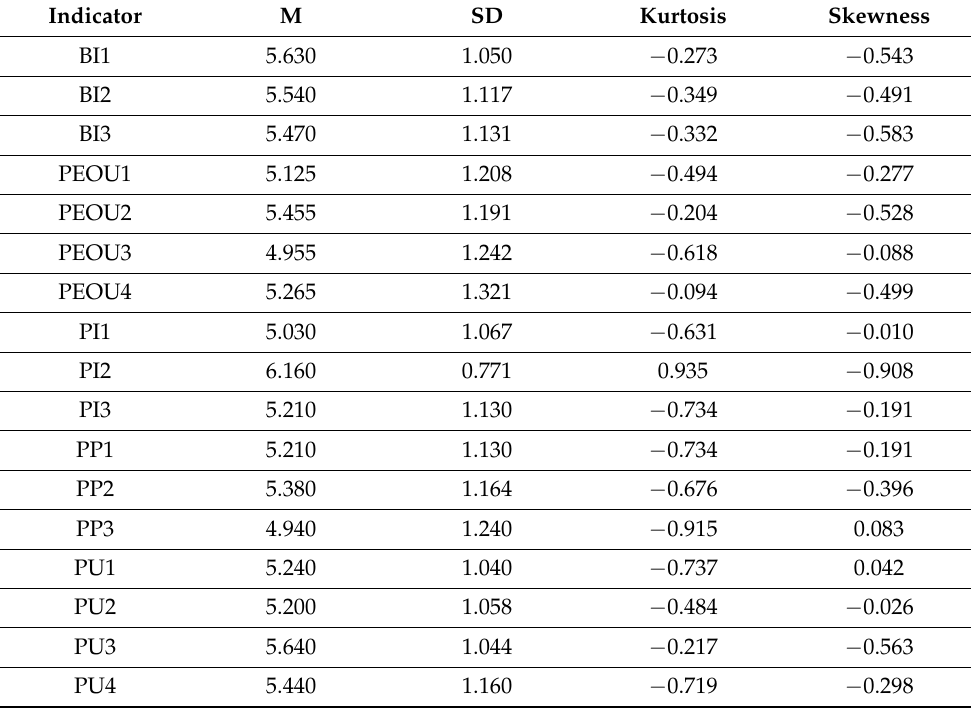
Table 3. Descriptive statistics of the